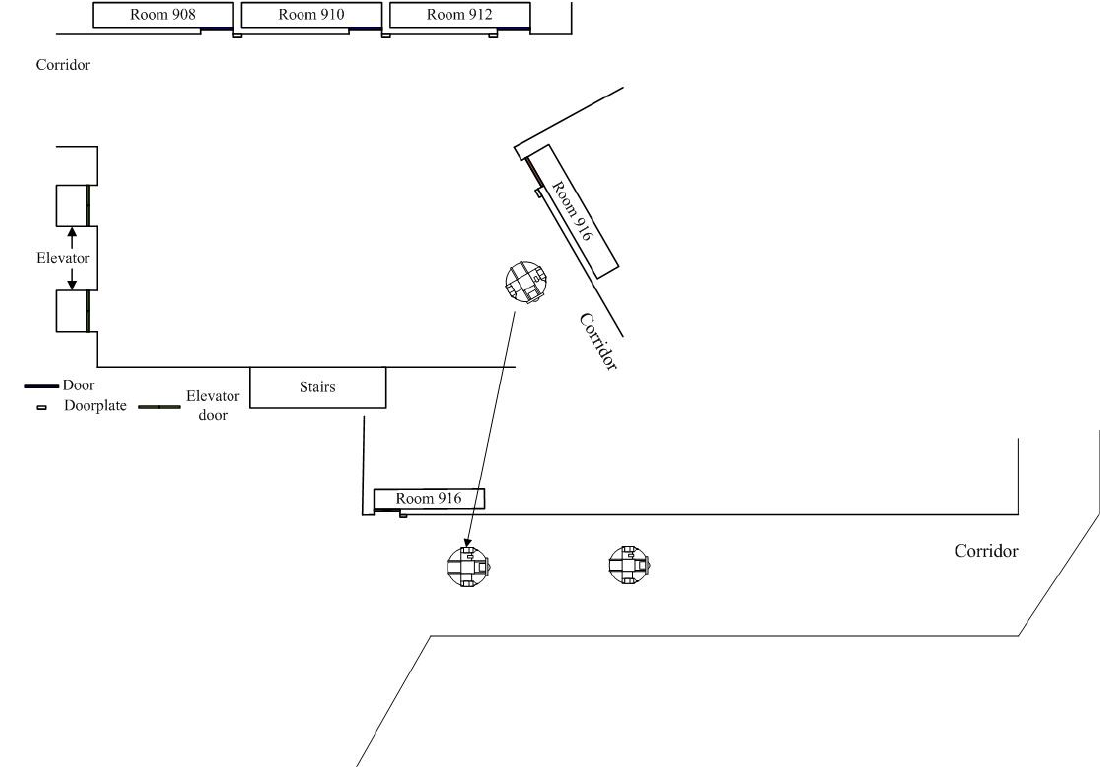
Figure 26. The corridor environment diagram.